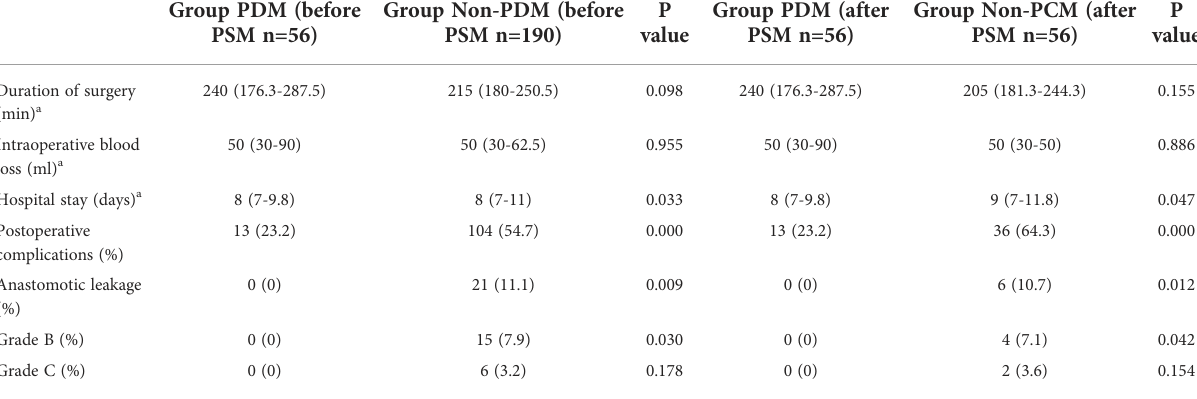
TABLE 6 Operative Outcomes and postoperative complication in rectal